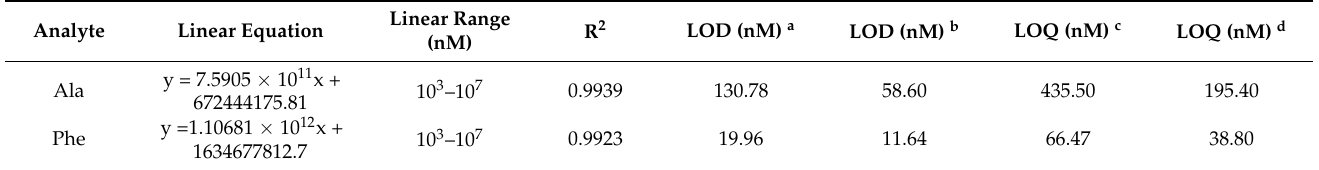
Table 1. Validation results of the LC-MS/MS method for the analysis of derivatized AAs.